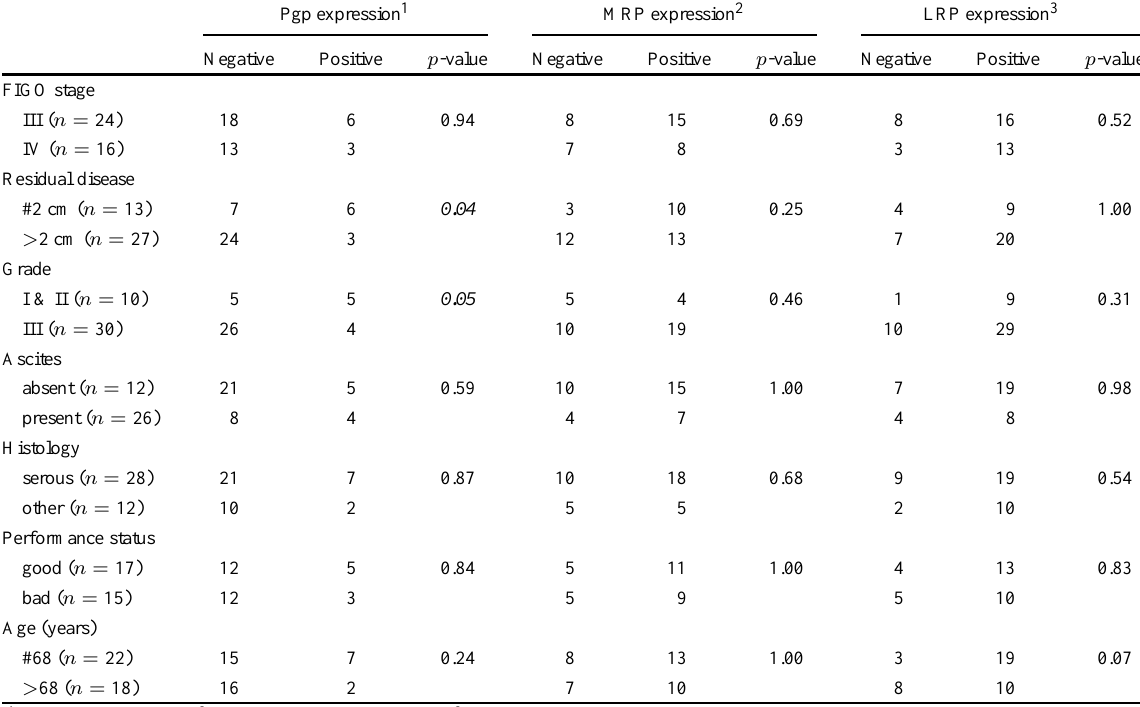
Correlations between clinicopathologic patient characteristics and the expression of MDR-related proteins in 40 patients with advanced ovarian cancer (tested with Pearson Chi-square statistics with Yates’ correction) Pgp expression